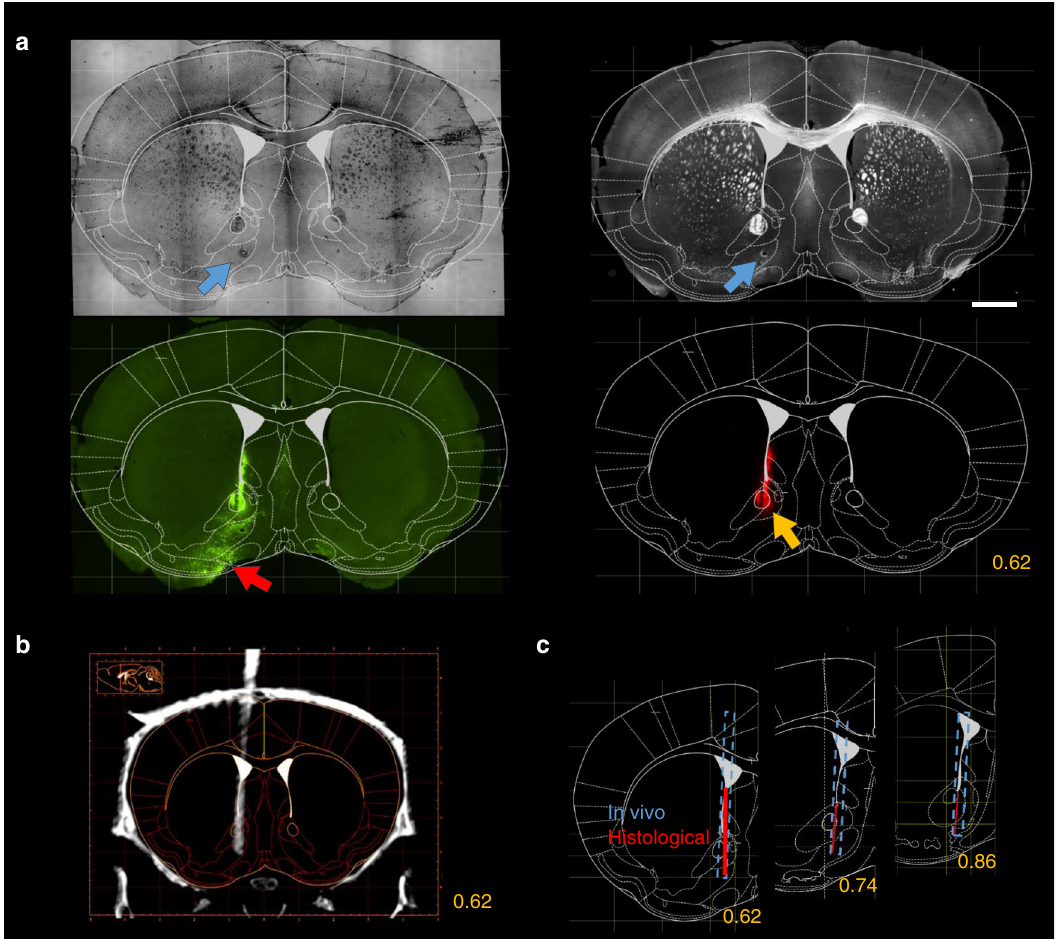
Fig. 7 Comparison of in vivo localization and post hoc histology. a Top, the Paxinos atlas was fi tted on coronal sections based on anatomical landmarks identi fi ed in the bright- fi eld (left) and dark- fi eld (right) images. Blue arrows, electrolytic lesion. Bottom, the atlas image was overlaid on fl uorescent images showing the virus infection at the target area (left, red arrow; green, eYFP) and the implant track (right, yellow arrow; red, DiI). Scale bar, 1 mm. b The corresponding coronal CT slice with the implant trajectory localized in vivo (grayscale image). c Comparison of the histologically reconstructed implant track (red line) and the in vivo localization (blue dashed line). Yellow numbers refer to the anteroposterior coordinates from Bregma in